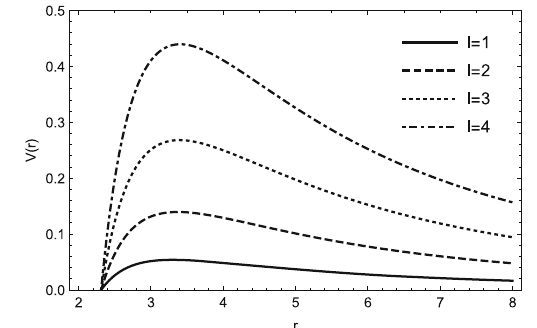
Fig. 1 The variation of the effective potential with r for l = 1 , 2 , 3 , 4, with the fixed a = 0 . 1, β = 1